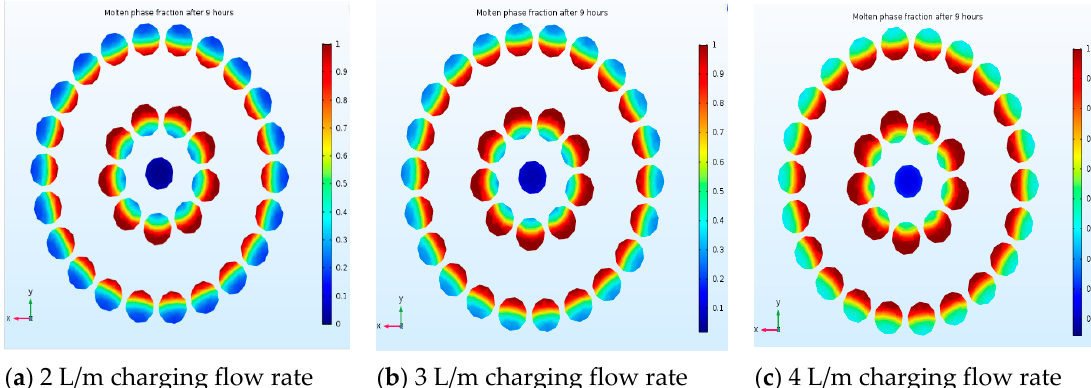
Figure 5. Melting fraction of phase change material (PCM) after charging period (9 h).